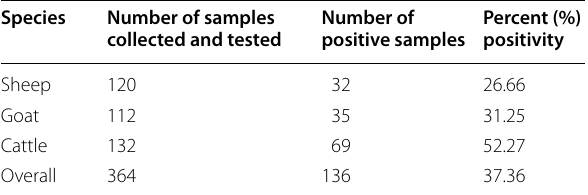
Table 4 Seroprevalence of anti-BTV antibodies among